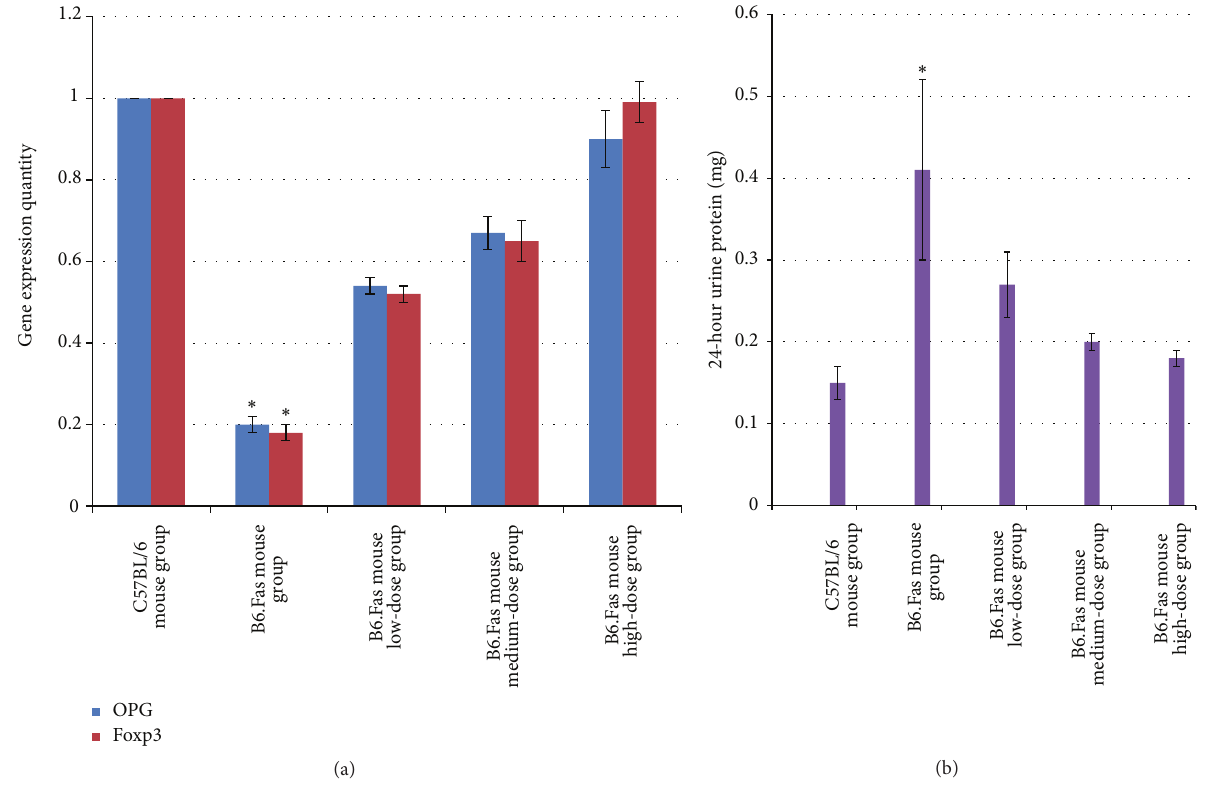
Figure 5: (a) Results of quantitative PCR tests for two genes in each group. ∗ 𝑃 < 0.01 compared to other groups. (b) Comparison of 24-hour urine protein levels among the groups. The values are expressed as the mean ± standard deviation ( 𝑛 = 10